Question: What type of chart is this?
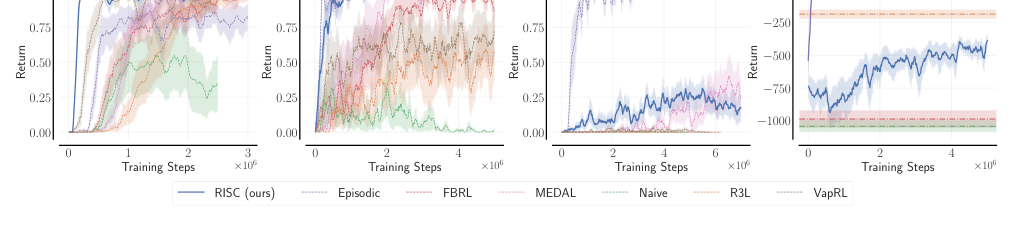
Answer: line